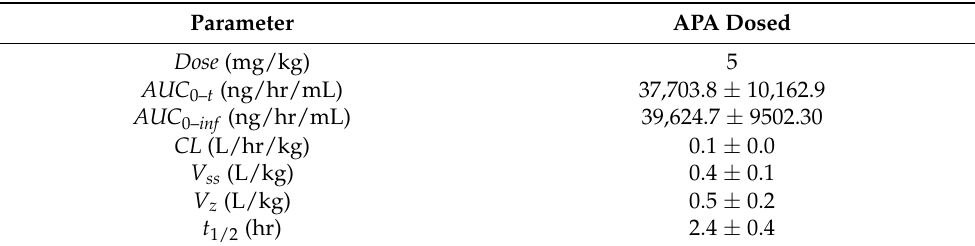
Table 3. Permeability of LW6 in Caco-2